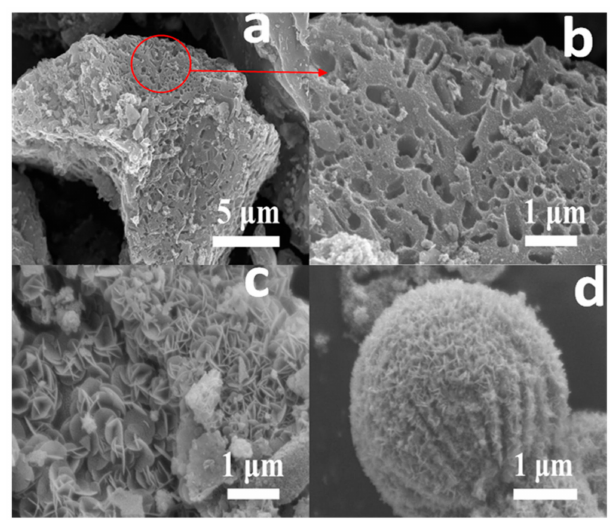
Figure 2. Scanning electron microscopy (SEM) images of AKB with a higher magnification ( a , b ); ( c ) Bi2MoO6/AKB nanocomposite (BKBC); and, ( d ) pure Bi2MoO6